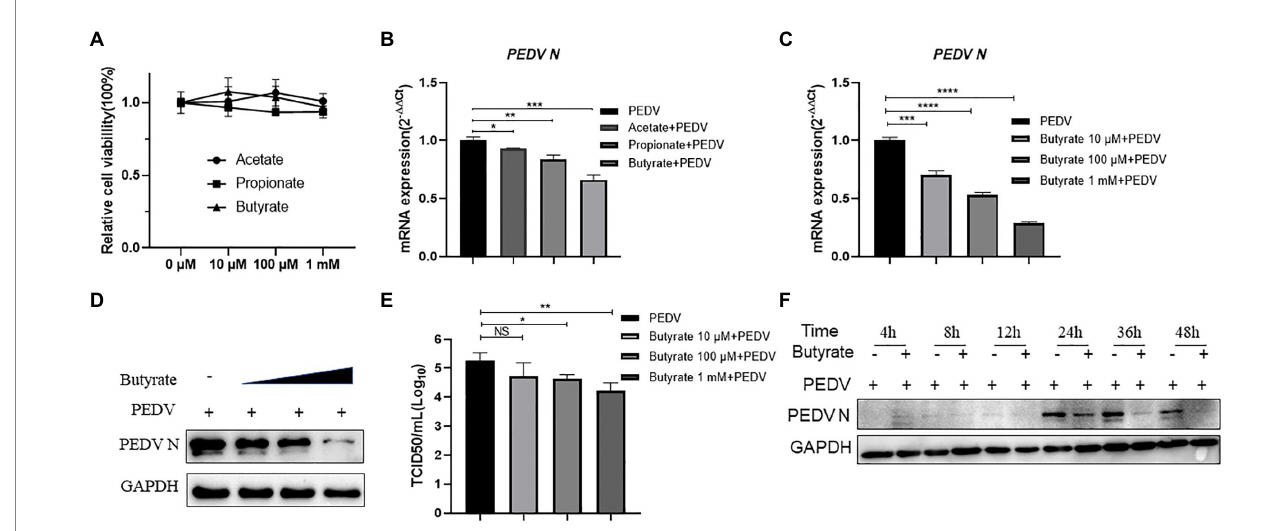
FIGURE 1 Butyrate pre-treatment protects IPEC-J2 against PEDV infection. (A) Effect of acetate, propionate, and butyrate on IPEC-J2 cells. Compounds at concentrations of 0 μ M, 10 μ M, 100 μ M, and 1 mM were added to IPEC-J2 cells and cultured for 48 h. (B) IPEC-J2 cells were pretreated with acetate, propionate, and butyrate at 500 μ M for 24 h and then infected with PEDV. (C,D) Butyrate inhibits PEDV infection. IPEC-J2 cells were pretreated with different concentrations of butyrate (10 μ M, 100 μ M, and 1 mM) for 24 h and then infected with PEDV (0.1 MOI) for 24 h in the presence of butyrate. (C) PEDV viral load detected using qPCR. (D) PEDV N protein levels detected using western blotting. (E) Viral titers determined using a TCID 50 assay. (F) PEDV N protein levels detected by western blotting at different time